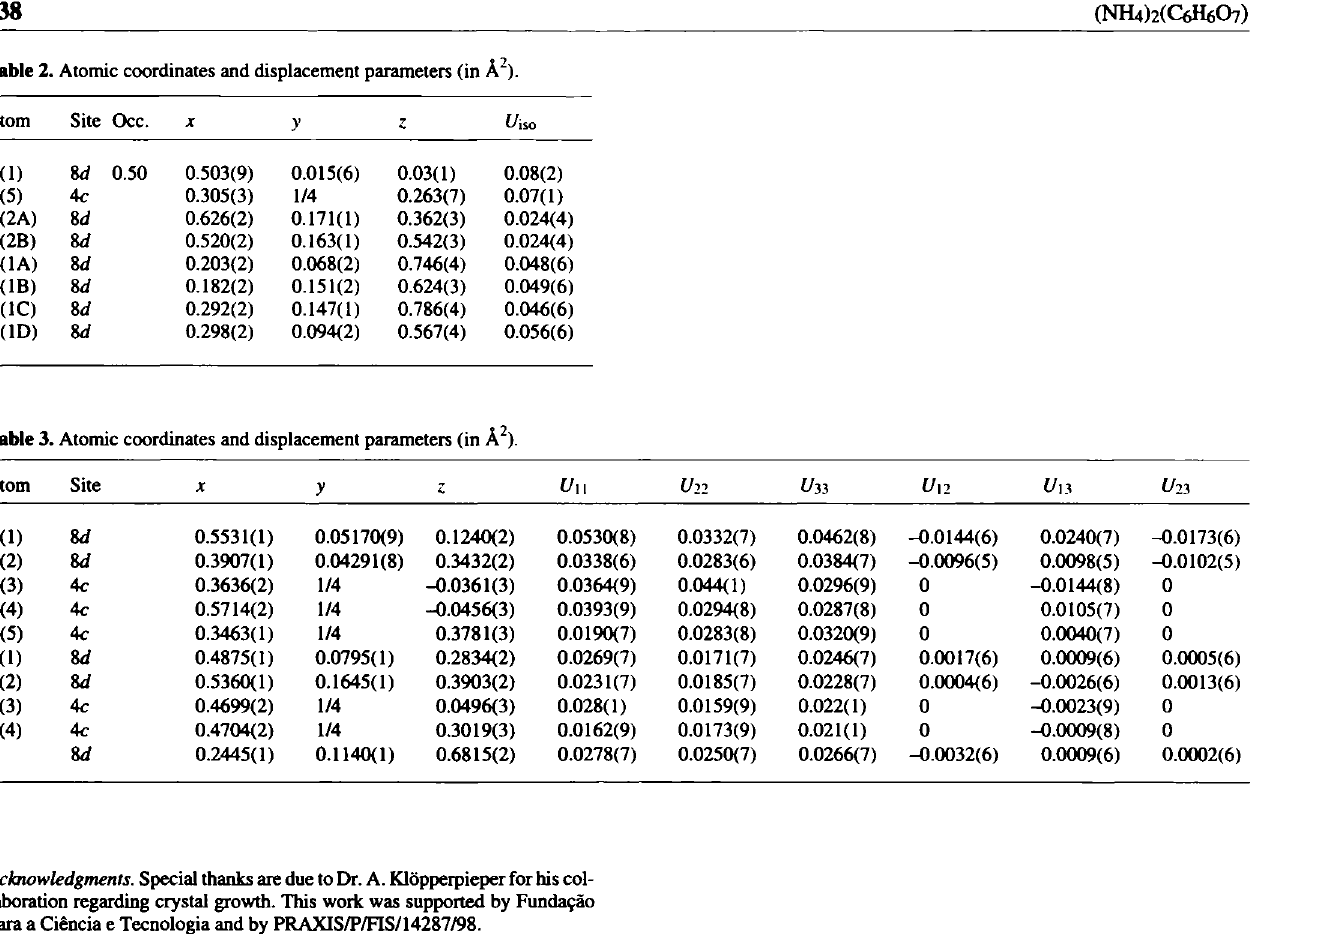
Table 2. Atomic coordinates and displacement parameters (in Â 2 ).